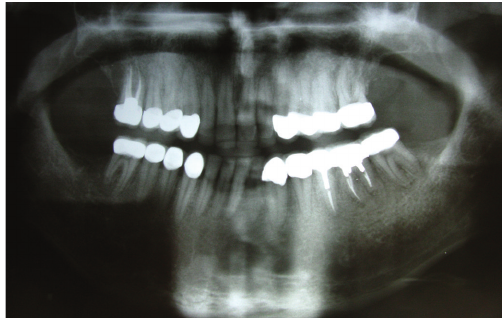
Figure 9: Posttreatment panoramic